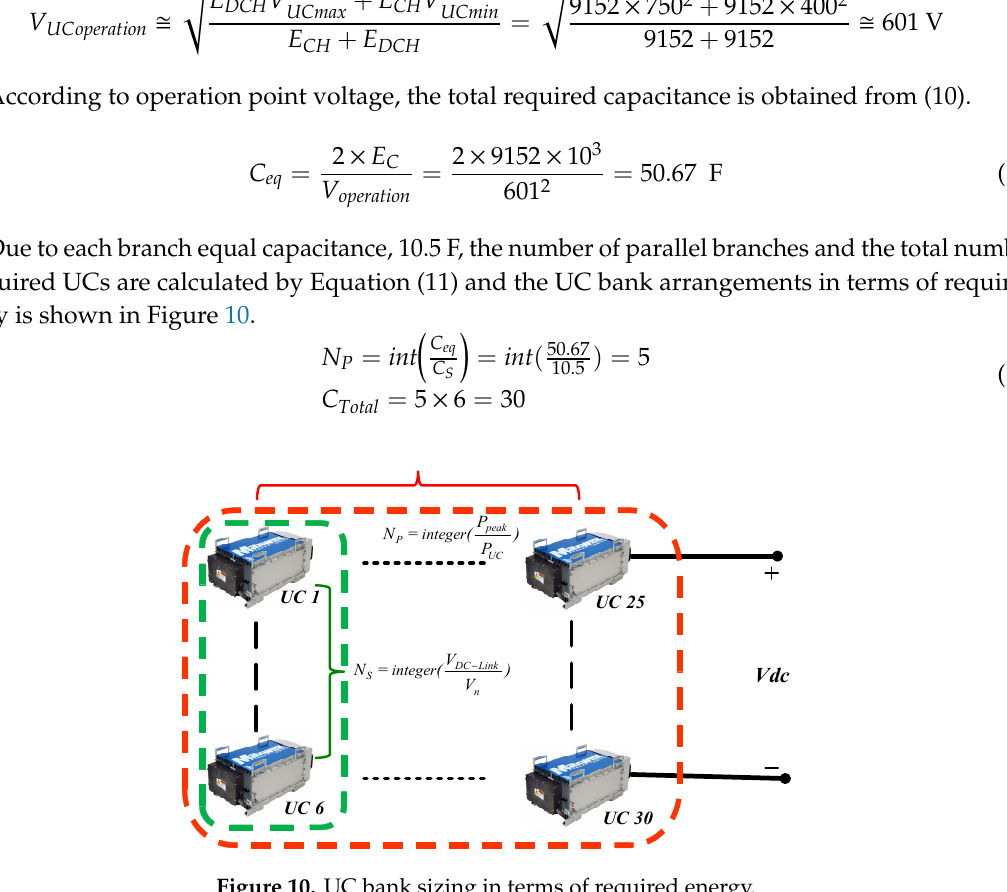
Figure 10. UC bank sizing in terms of required energy.